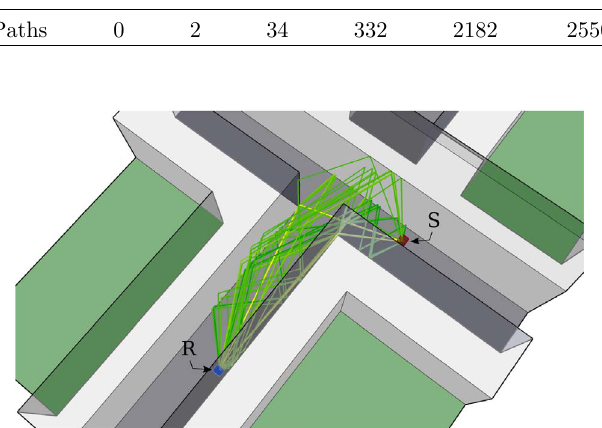
Figure 10. Visualization of remaining 37 propagation paths after perceptual culling from source S to receiver R . Yellow dyed segments depict stronger diffraction components, green indicates more re fl ections in the path.